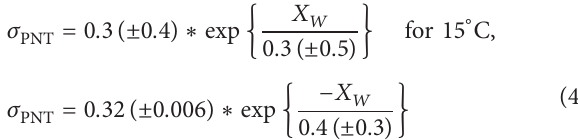
Figure 11: PNT in water-ethanol mixtures at 40 ∘ C. The best fit exponential curve is drawn for each